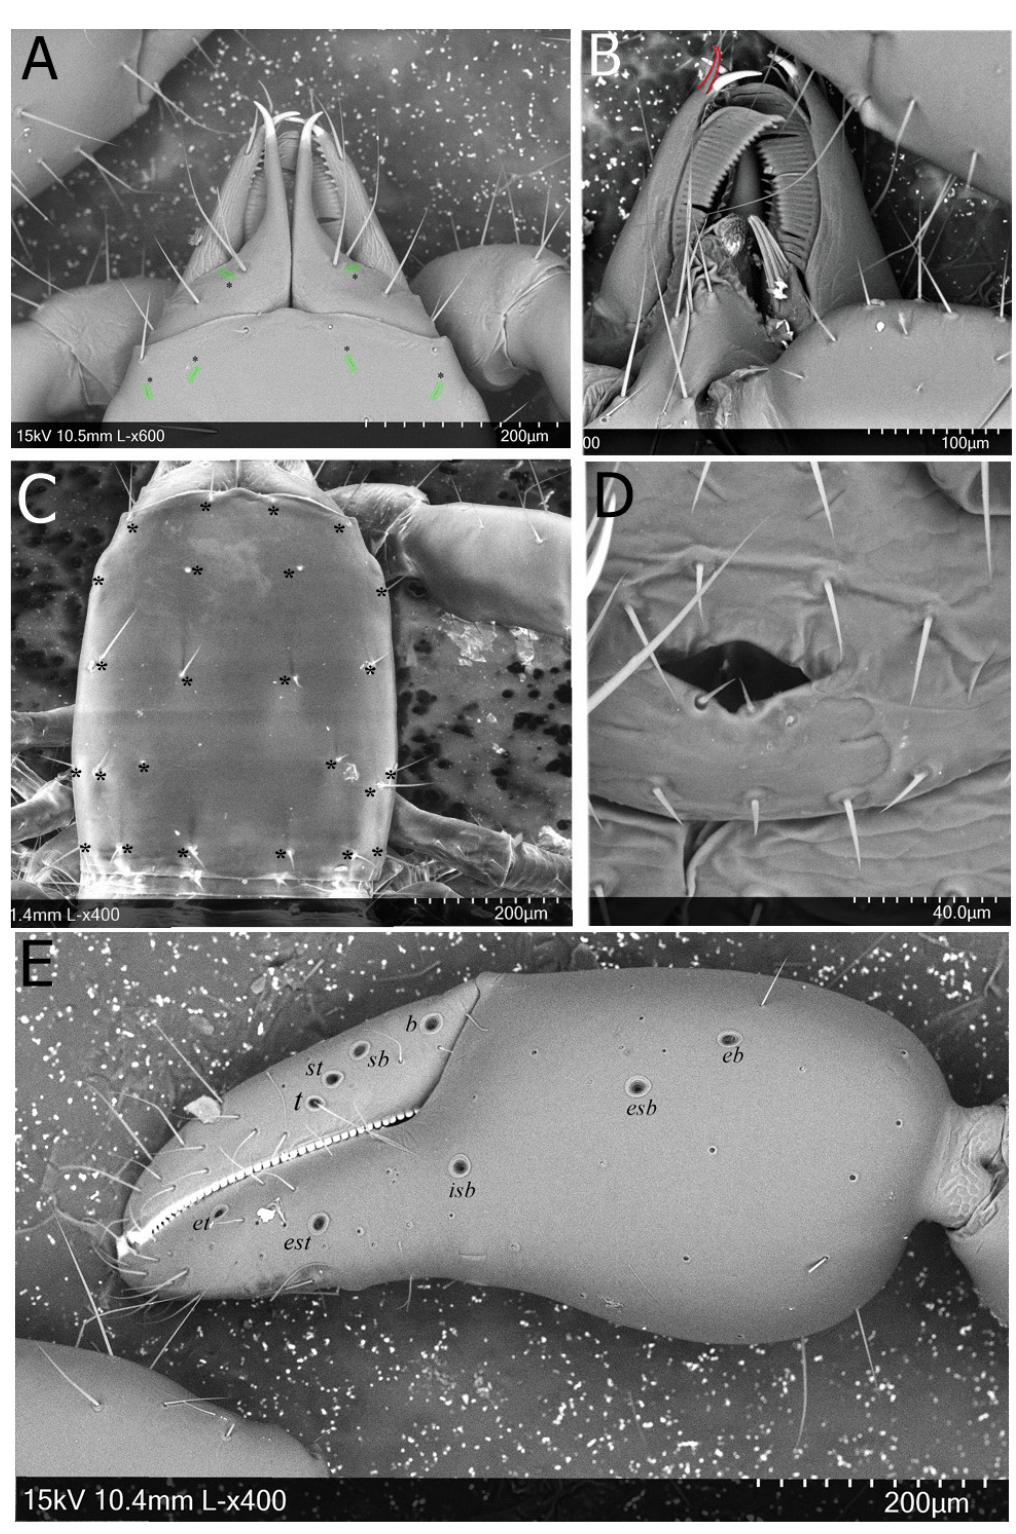
Fig. 11. Scanning electron micrographs of Ideobisium sonqo sp. nov. A . Chelicera and anterior margin of carapace in dorsal view, showing lyrifissures. B . Chelicera, showing galea in ventral view. C . Carapace with asterisks next to setae. D . Genital area. E . Chela in retrolateral view, showing trichobothria. A–C, E: paratype, ♂ (ZMH A0003690); D: paratype, ♂ (ZMH